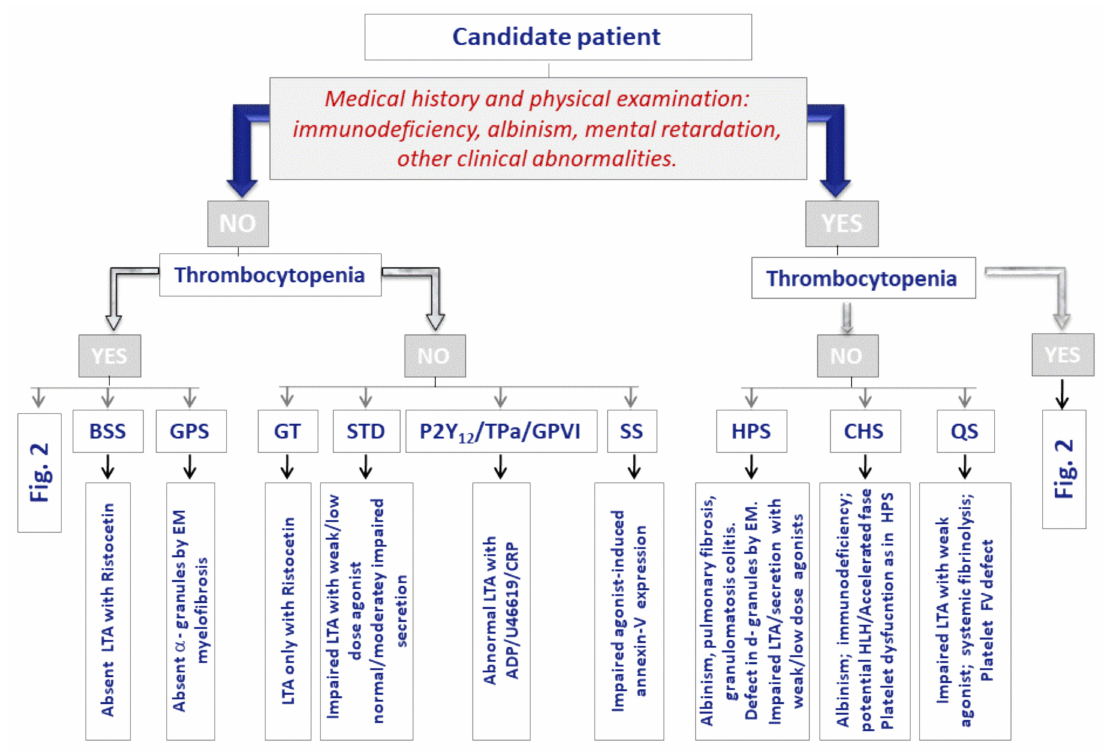
Figure 3. Diagnostic approach for suspected cases of inherited platelet function disorders. BSS: Bernard-Soulier Syndrome; GPS: Gray Platelet Syndrome; GT: Glanzmann thrombasthenia; STD: Signaling transmission defect (deficiencies in enzymes, G-proteins, CalDAG-GEF1, other signaling proteins); Specific defects in platelet receptors P2Y12 (ADP), Tpa (TxA2) or glycoprotein VI (GPVI) (collagen); SS: Scott Syndrome; HPS: Hermansky-Pudlak Syndrome; CHS: Chediak-Higashi Syndrome; QS: Quebec Syndrome. EM: electron microscopy; LTA: light transmission aggregometry; U46619:TxA2 analog; CRP: collagen-related peptide; Figure 2: Figure